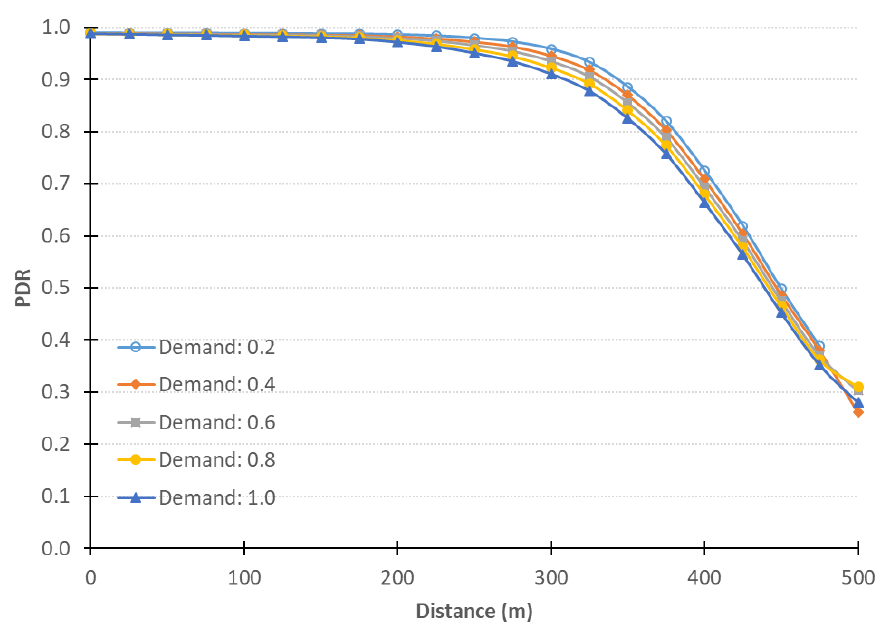
Figure 7. QNET results using different loading percentages.